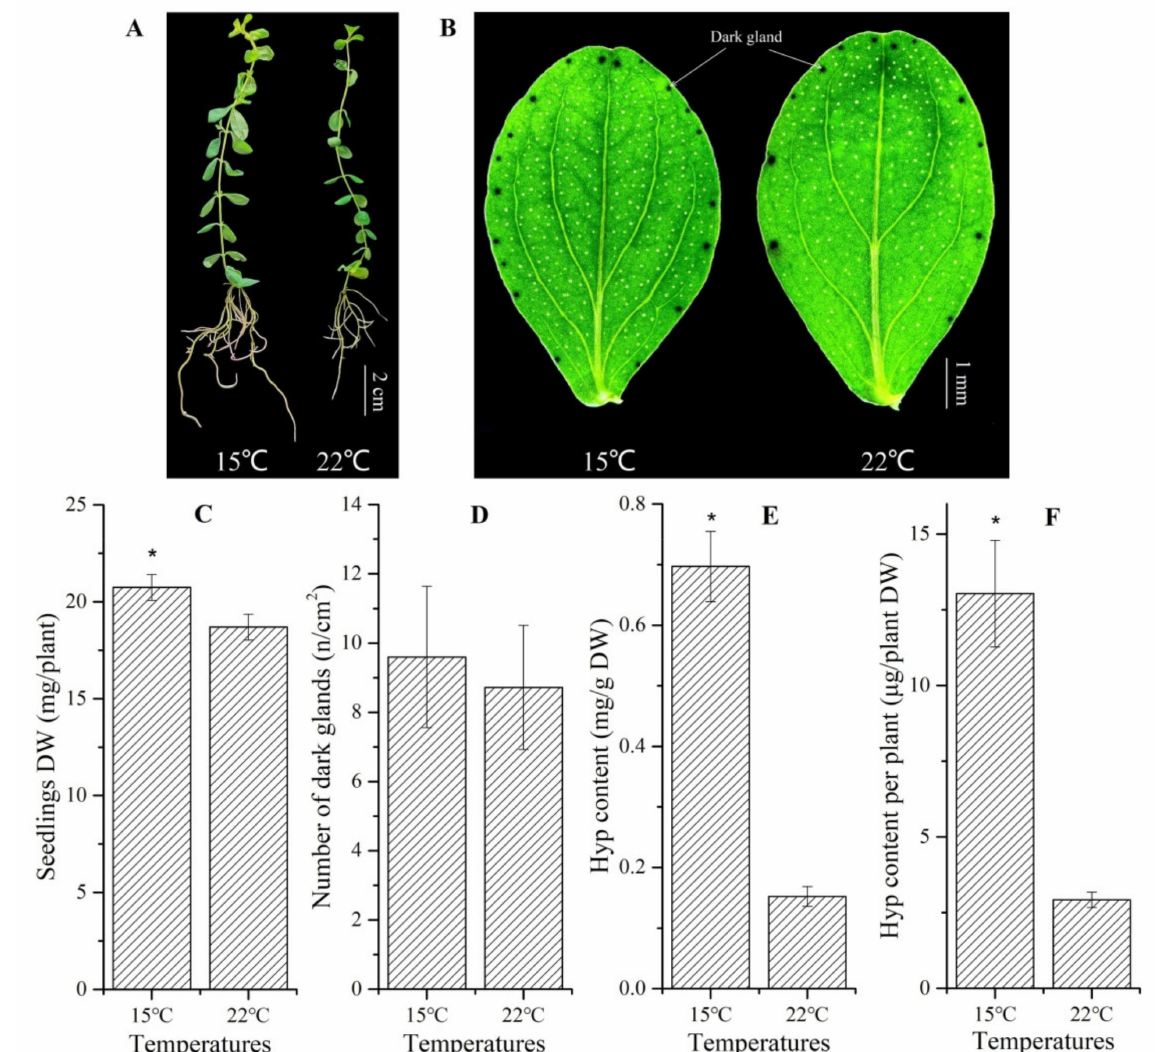
Figure 2. Biomass, dark glands and Hyp content in Hypericum perforatum seedlings grown at 15 and 22 ◦ C. Dry weights (DW) of whole seedlings ( A , C ), number of dark glands ( B , D ) and Hyp contents on a DW and per plant basis (( E , F ), respectively). The “*” is considered significant at p < 0.05 between 15 and 22 ◦